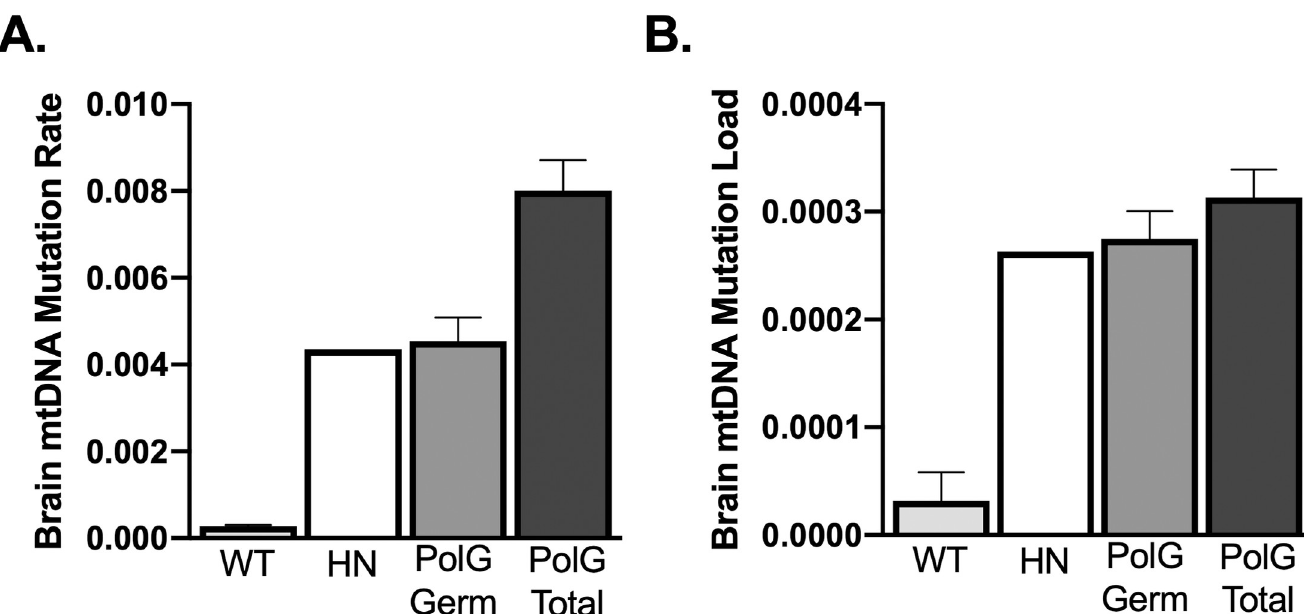
Fig 4. mtDNA mutation analysis in HN and WT mice. A, B. Relative comparison between wild type (WT) (n = 2 composed of one young (3 months) and one old (25 months), homozygous negative (HN) (n = 1 (12 months)), and PolG (germ n = 15, total n = 17) brain mtDNA mutation rate and load, collapsed across exercised and sedentary